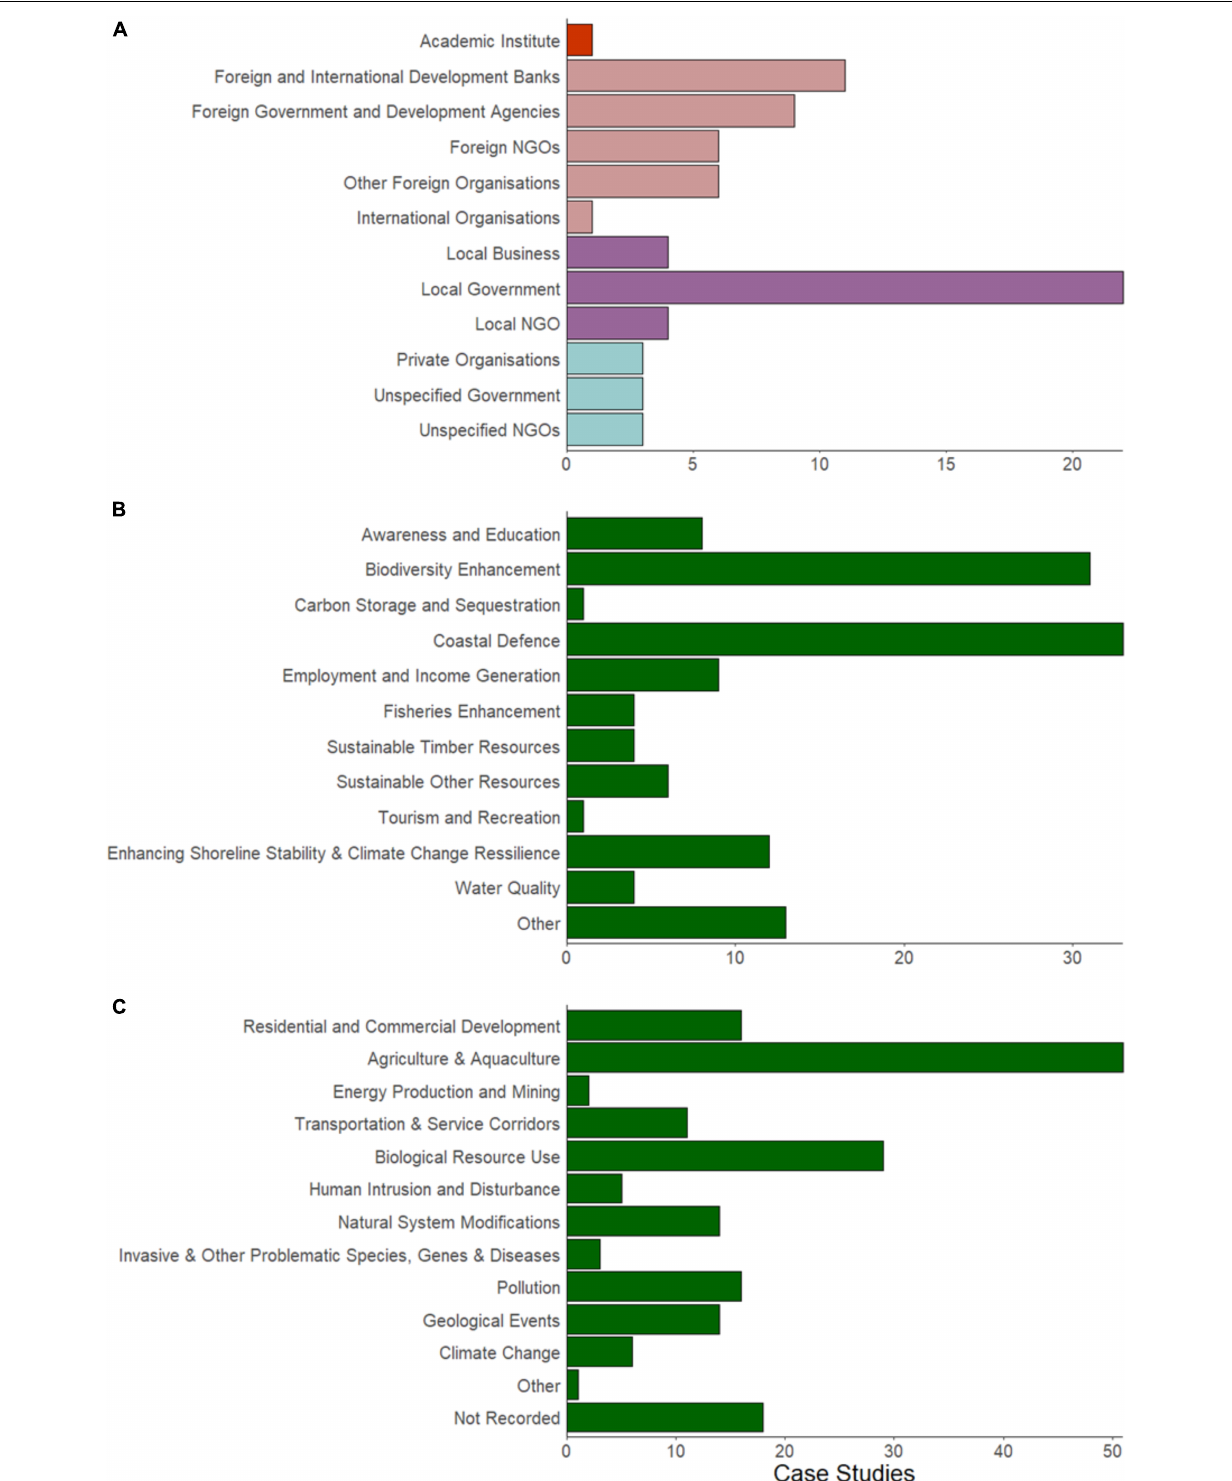
Frontiers in Forests and Global Change |